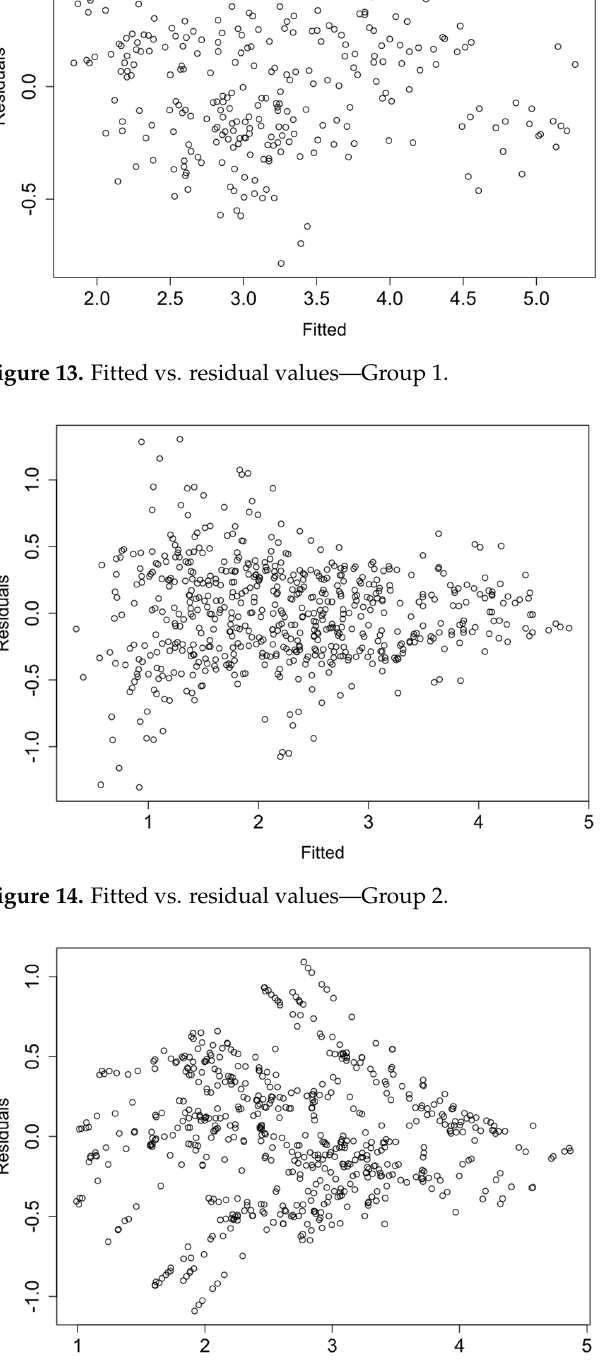
Figure 16. Fitted vs residual values—Group 4.